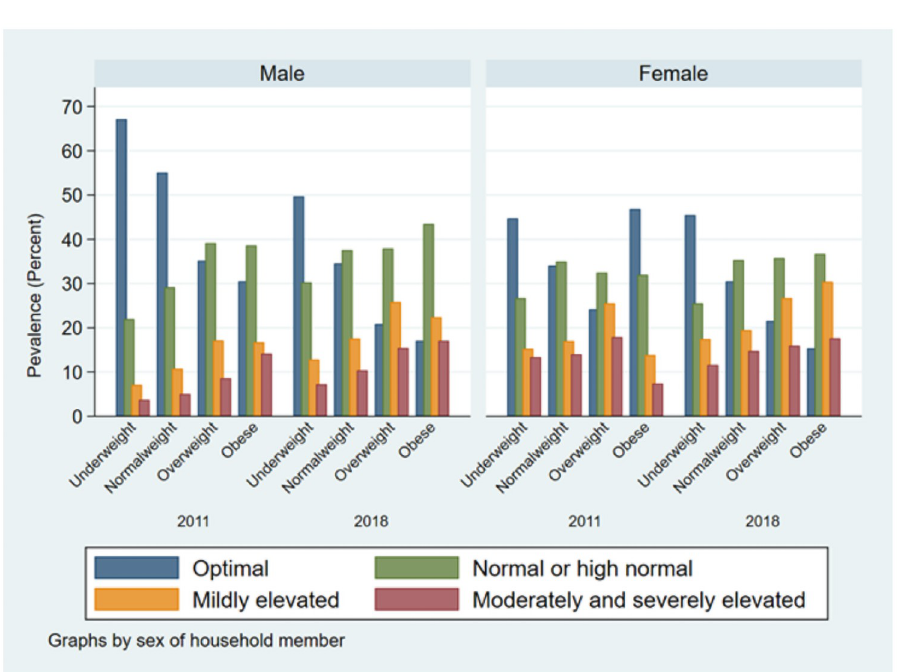
Fig 2. Blood pressure categories by BMI, sex, and survey year.